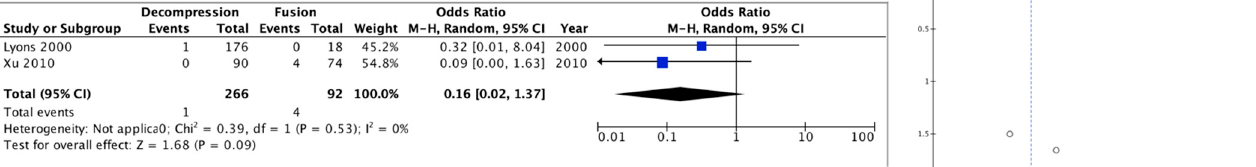
Figure A12. Infection.